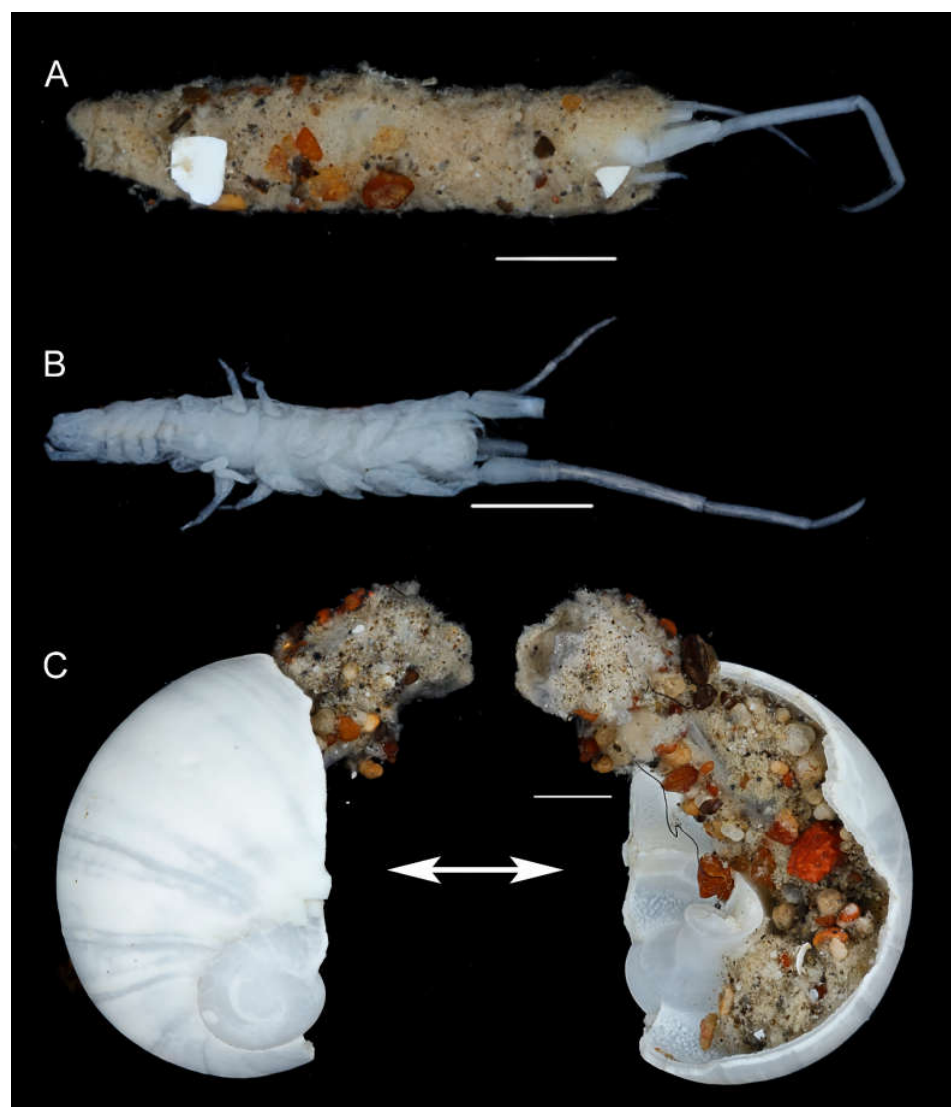
Figure 10. Unciola conchicola sp. nov., juvenile, ZMHK 62085, South Island, Iceland Basin, 1921 m. ( A ) in tube made of sand; ( B ) removed from tube; ( C ) tube in pteropod shell, Scale: 1 mm. Unciola icelandica sp. nov.